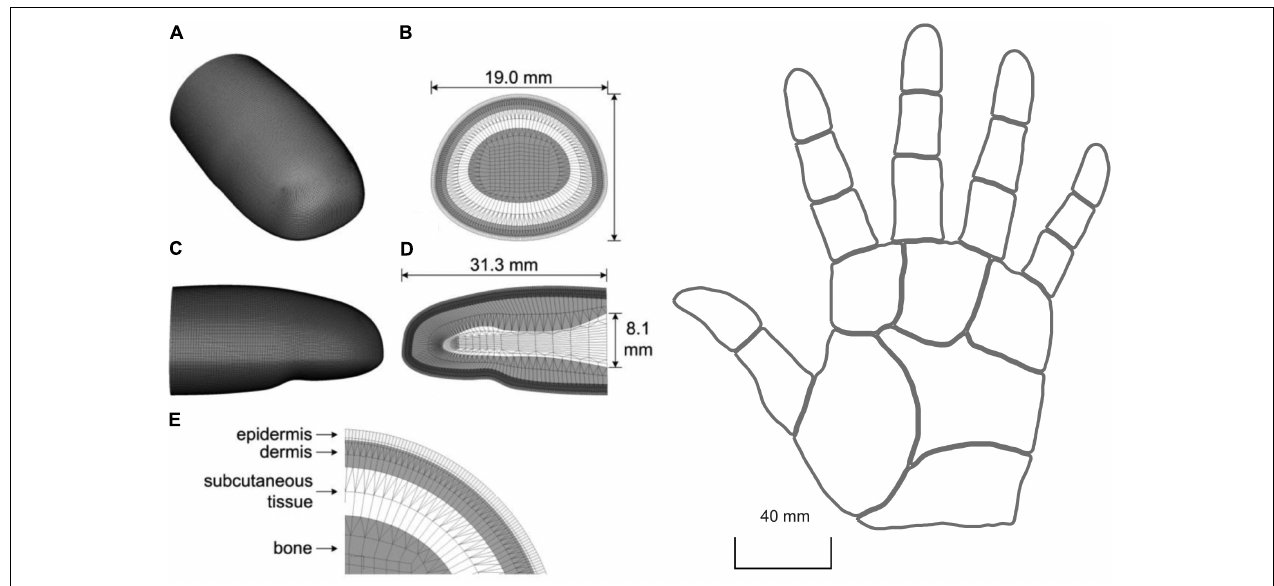
FIGURE 6 | Left: 3D mesh of human distal phalange in Gerling et al. (2013). (A) overall mesh, (B) cross section of the mesh near the interconnect with the middle phalange, (C,D) longitudinal section for both the outer surface and inner mesh, and (E) four layers of microstructures. In (E) the epidermis is 0.471 mm thick (0.371 mm stratum corneum and 0.1 mm living epidermis) and the dermis is 1.153 mm thick. Right: 2D reconstruction of the virtual hand in Saal et al. (2017). Here, the skin is treated as a flat surface. (Left) republished with permission of The Institute of Electrical and Electronics Engineers, Incorporated (IEEE), from Gerling et al. (2013); permission conveyed through Copyright Clearance Center,